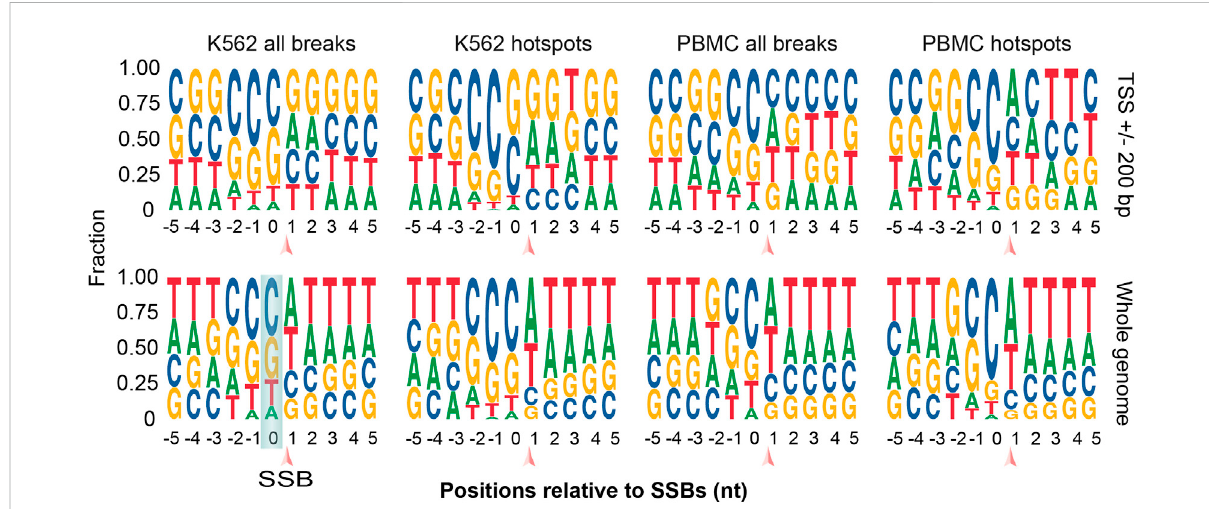
FIGURE 6 Sequence motif analysis in the immediate vicinity of all breaks and hotspots. Logo plots for the sequences around all SSBs or hotspots located within ±200 of TSSs (top) or anywhere in the genome (bottom) are shown for K562 and PBMCs. SSBs are located between the positions 0 and 1 as indicated by the arrows. See Supplementary Table S6 for more